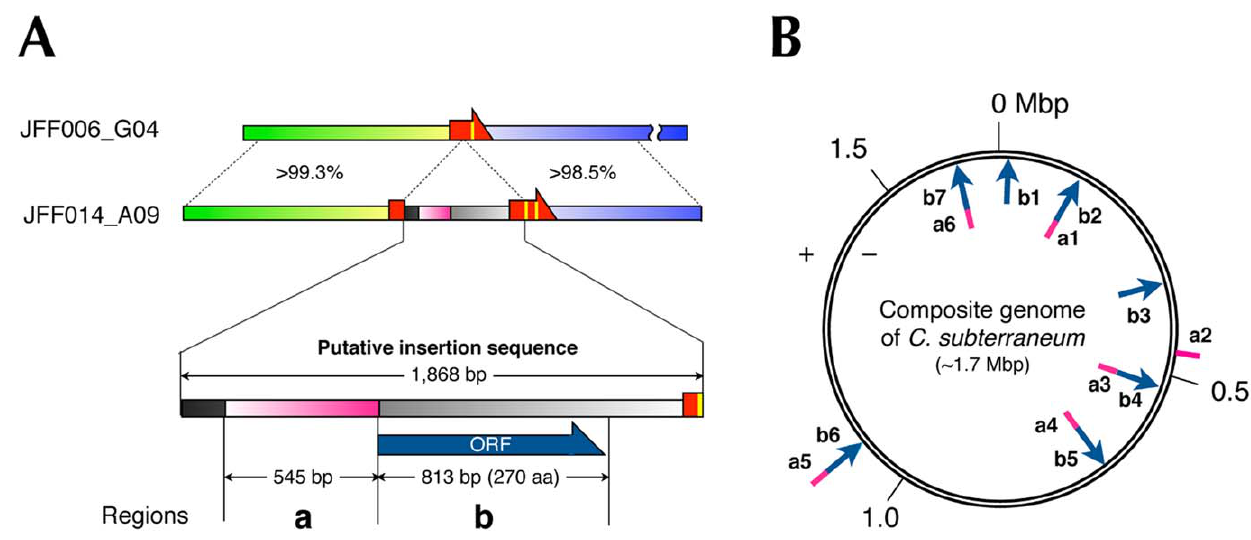
Figure 3. Characterization of the insertion sequence found at the tRNA Thr gene locus. (A) Schematic representations of clones JFF006_G04 and JFF014_A09, and the enlarged putative insertion sequence. The colors correspond to those used in Figure 2. Homologous regions between the cloned sequences are linked by a dashed line and the similarity scores are shown. The two regions ‘a’ (pink) and ‘b’ (blue arrow) are shown, along with their respective lengths. (B) Regions homologous to the ‘a’ and ‘b’ sequences (at the nucleotide level for ‘a’ and amino acid level for ‘b’) are mapped to the schematic representation of the composite genome, and each is numbered (a1–a6 or b1–b7).